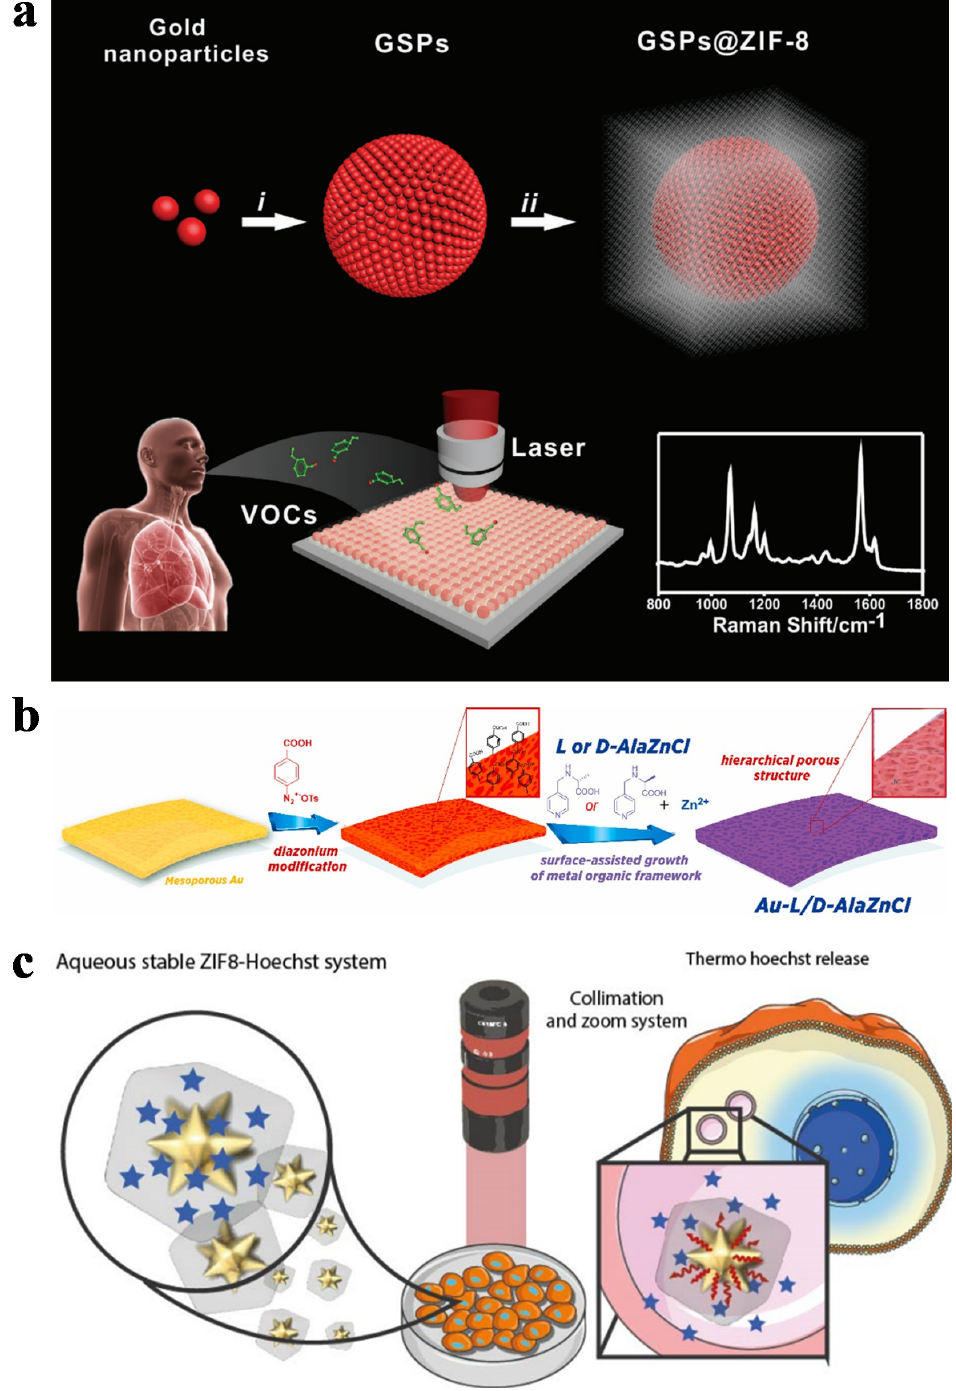
Figure 4. ( a ) GSPs@ZIF-8 SERS detection: (i) gold nanoparticles assembled into GSPs, (ii) ZIF-8 shell coated on GSP surface. [76]. ( b ) Schematic diagram of preparing layered porous AlaZnCl-Au film [77]. ( c ) Au@ZIF-8 Drug release and monitoring process [78]. In medical treatment, drug carriers based on MOF have also made great progress. Horcajada et al. [78] Au@ZIF-8 nano-composite materials are used to monitor the process of encapsulating active molecules in living cells and to drive the release of thermoplastic